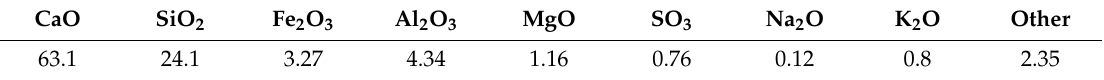
Table 1. Chemical composition of cement